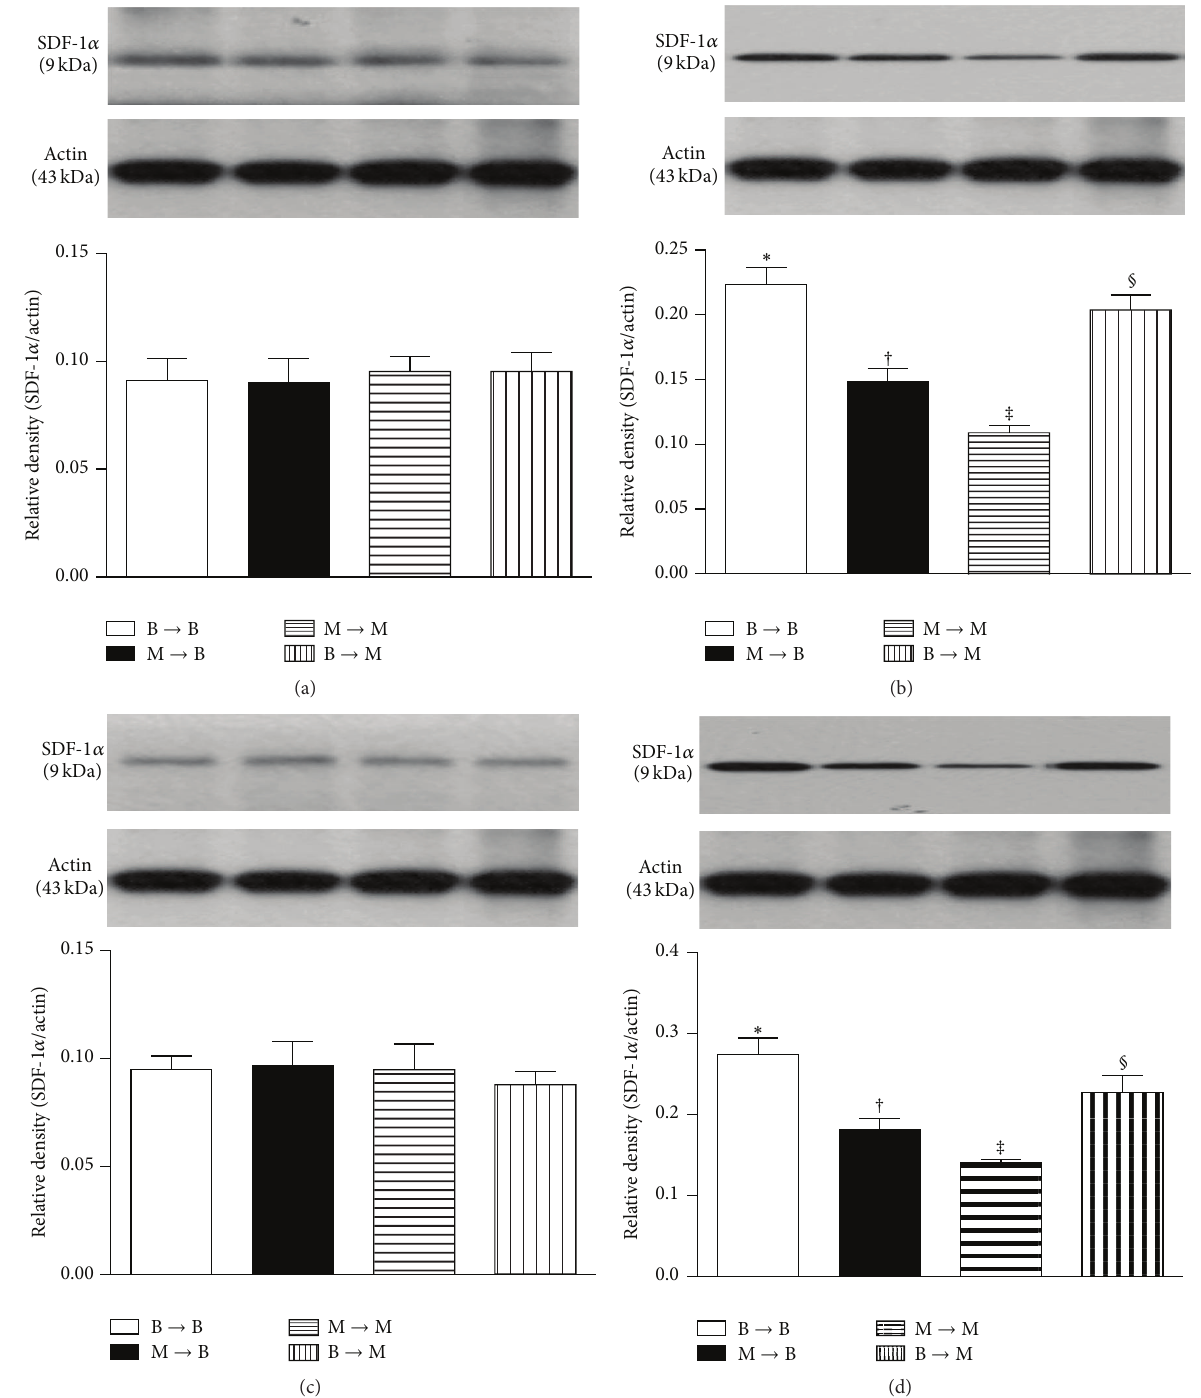
Figure 9: Protein expression of stromal cell-derived factor- (SDF-) 1 𝛼 in ischemic quadriceps at day 14 after critical limb ischemia (CLI) induction. (a) At sham control (SC) treatment condition, SDF-1 𝛼 did not differ among four groups, 𝑝 = 1.0 . (b) At CLI subgroup, groups with different symbols ( ∗ , † , ‡ , and §), 𝑝 < 0.05 . (c) At SC + tPA treatment condition, SDF-1 𝛼 did not differ among four groups, 𝑝 = 1.0 . (d) At CLI + tPA subgroup, groups with different symbols ( ∗ , † , ‡ , and §), 𝑝 < 0.05 . All statistical analyses were performed by one-way ANOVA followed by Bonferroni multiple comparison post hoc test. tPA = tissue plasminogen activator. 𝑛 = 6 for each